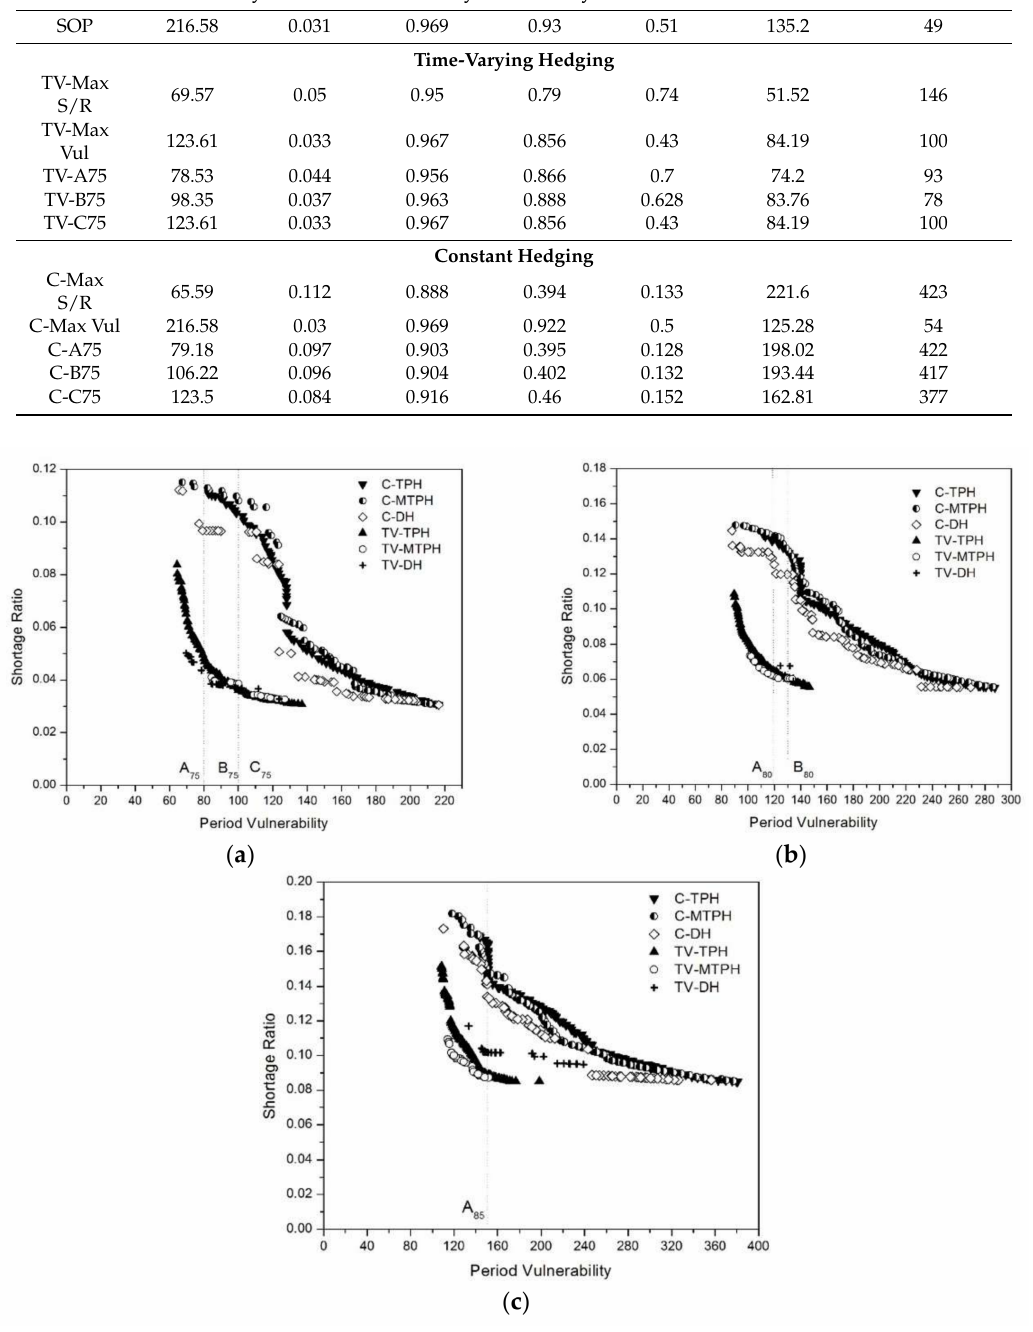
Figure 5. Pareto fronts for two point linear hedging, modified two point hedging and discrete hedging at 75%, 80% and 85% demand levels—Comparison of time-varying and constant